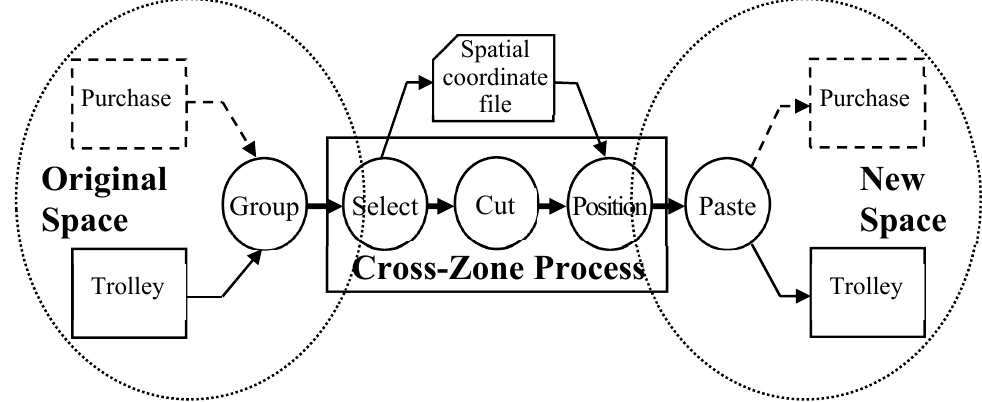
Figure 3. Flowchart of the cross-zone navigation execution process.